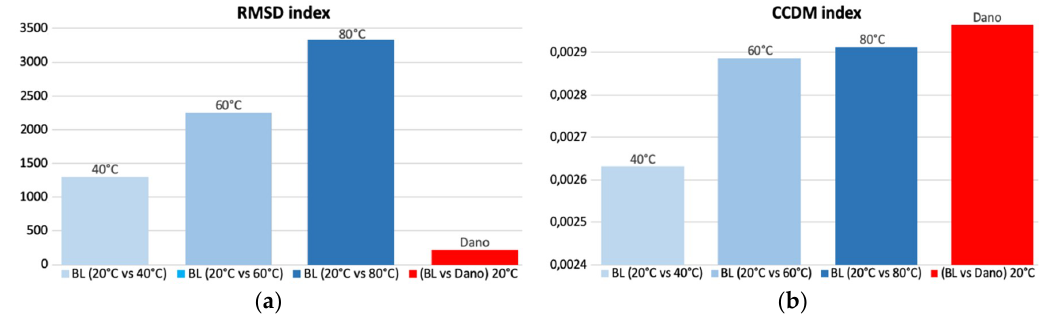
Figure 10. Damage metrics and the effect of temperature pipe-1/PZT-1: ( a ) RMSD and ( b ) CCDM.